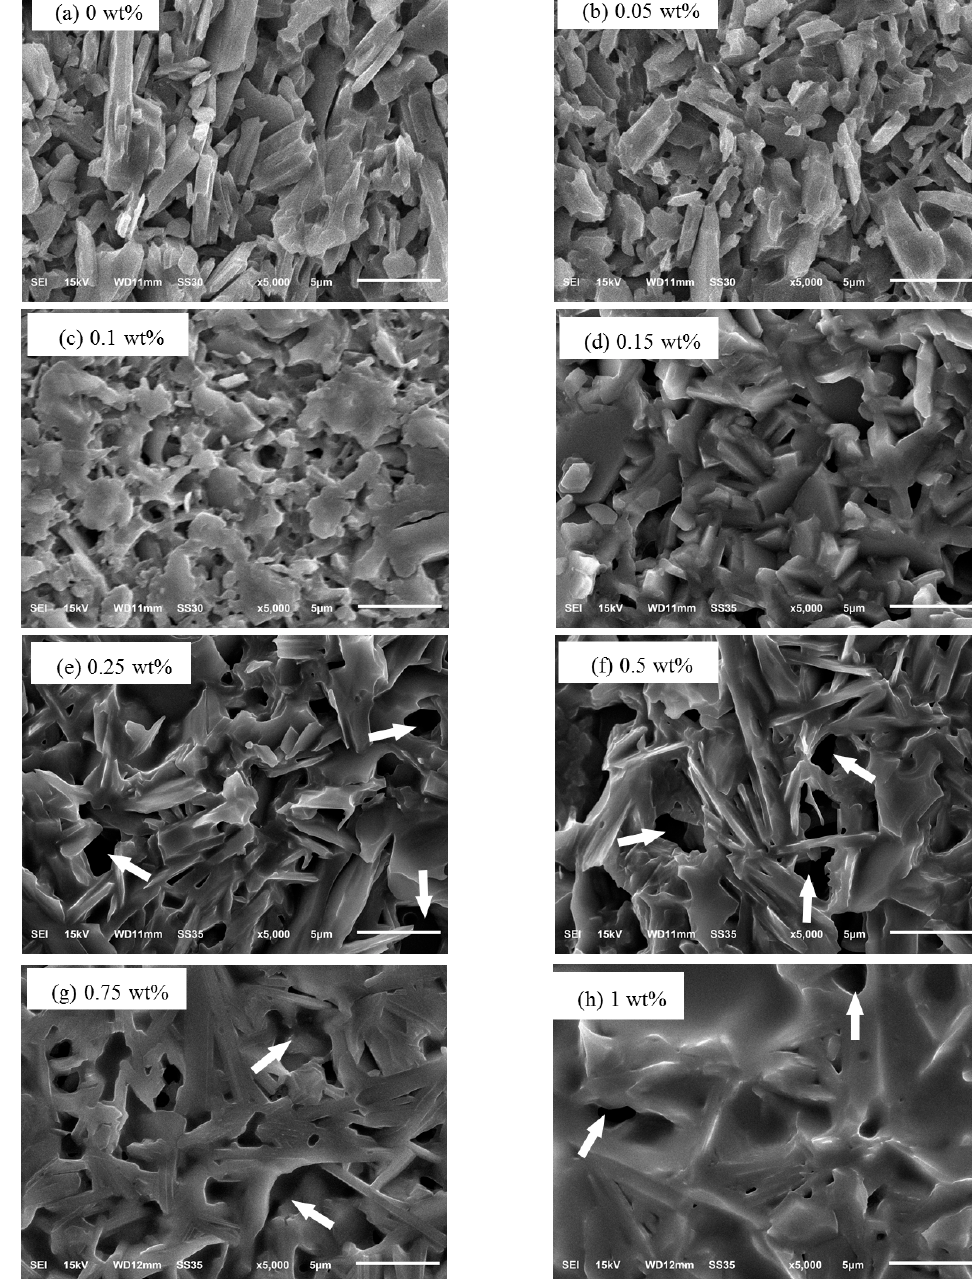
6 of 11 Figure 4. XRD spectra of the sinters for different amounts of Cr 2 O 3 doping (sintering temperature: 1450 ° C) . Table 2. The β ”-Al 2 O 3 phase contents of the sinters for different amounts of Cr 2 O 3 doping. Cr 2 O 3 wt%.